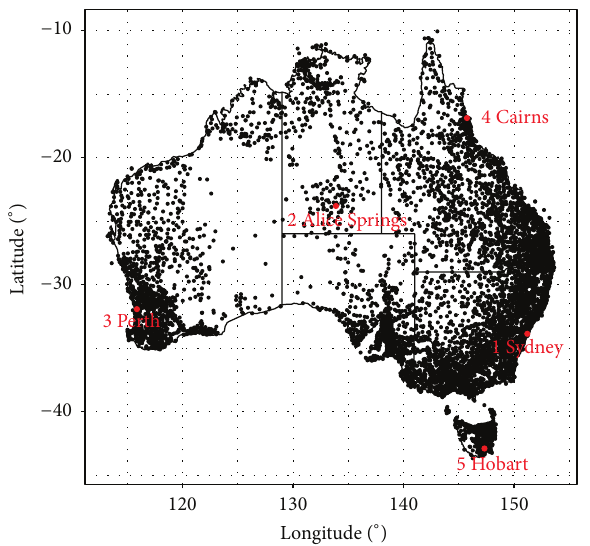
Figure 1: Map showing stations from the period of 1998 to 2013 in the GHCN-Daily dataset. A total of 8361 stations are shown here; however, on any given day between 1 Jan 1998 and 31 Dec 2013, the number of stations with usable precipitation observations varied in the range of 4500 to 6500. The red dots with labels from 1 to 5 denote the locations of Sydney, Alice Springs, Perth, Cairns, and Hobart, respectively, which are specifically referred to in Section 3. Refer to the text for more